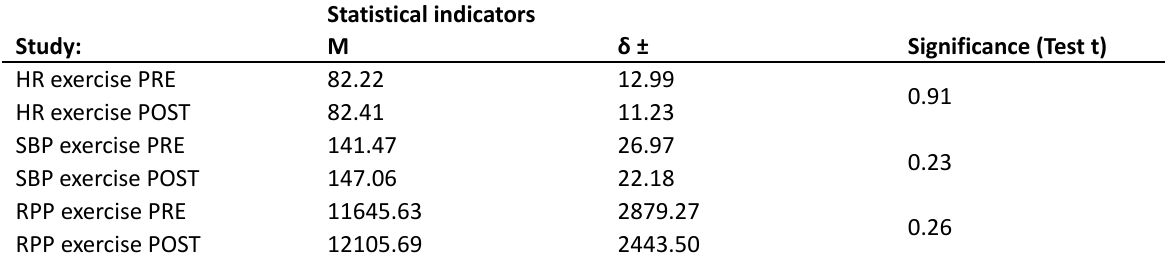
Table 4. Changes in haemodynamic indices 6MWT (before and after the rehabilitation cycle) Statistical